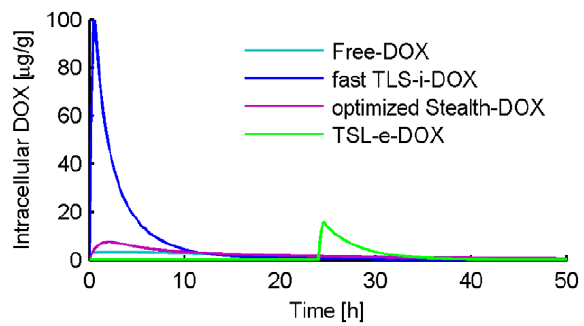
Figure 7. Comparison of intracellular tumor DOX concentration for different DOX